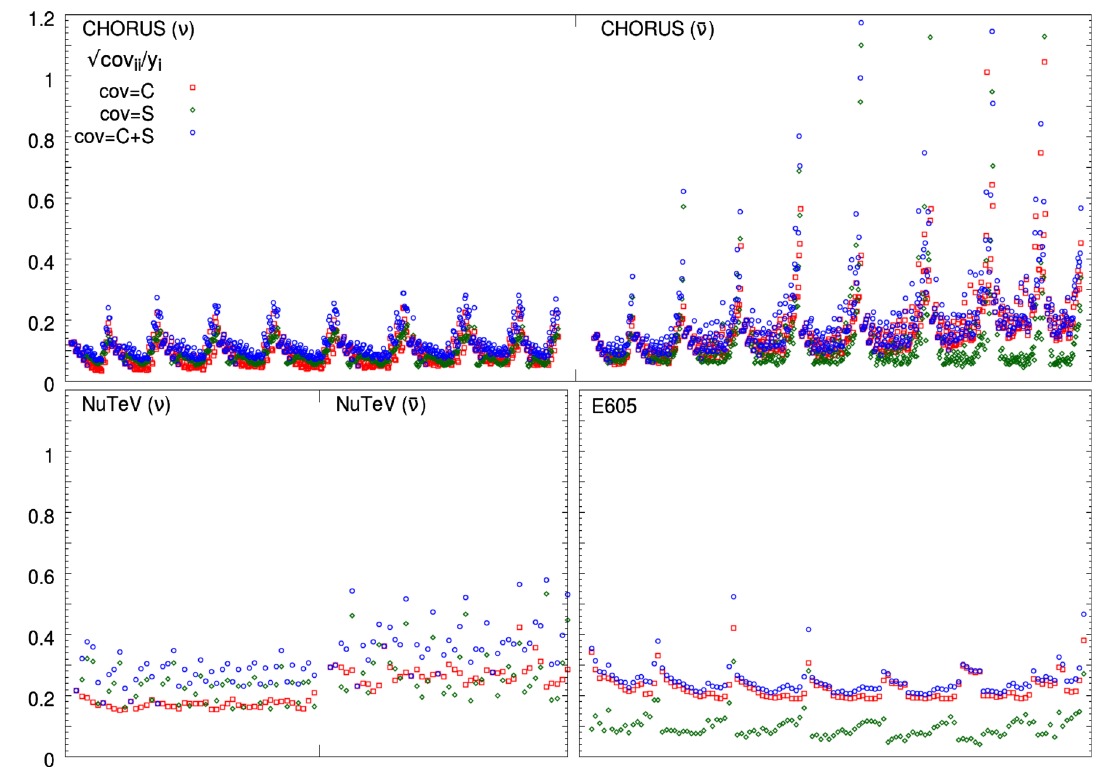
√ cov ii / D i , for CHORUS, NuTeV